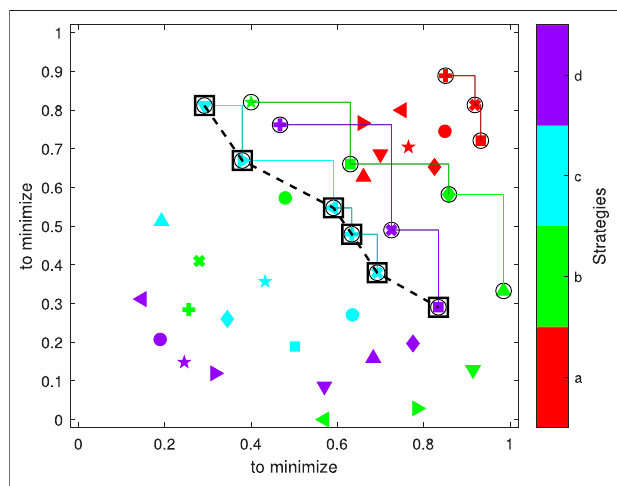
FIGURE 4 | Pareto anti-fronts of the worst-case Pareto-front strategies (black circles connected by colored stair-graphs, see color-bar). The worst- case Pareto front is depicted by dashed-line connected black squares. Both axes are aimed to be minimized.